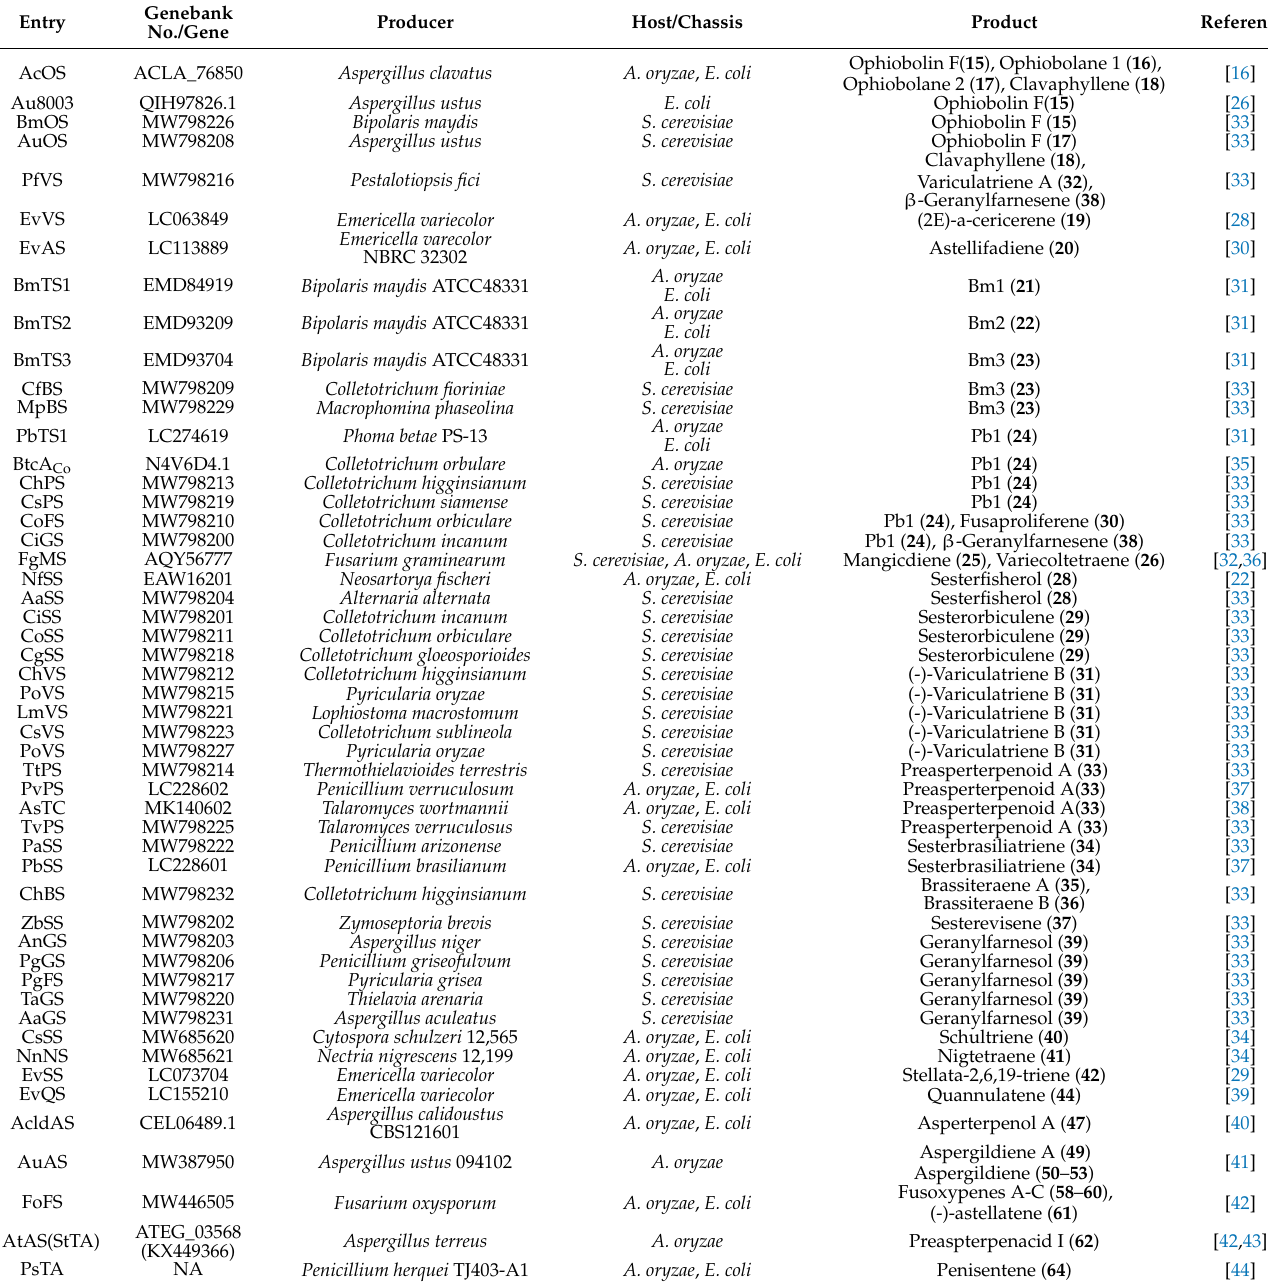
Table 1. The identified PTTSs from fungi and their